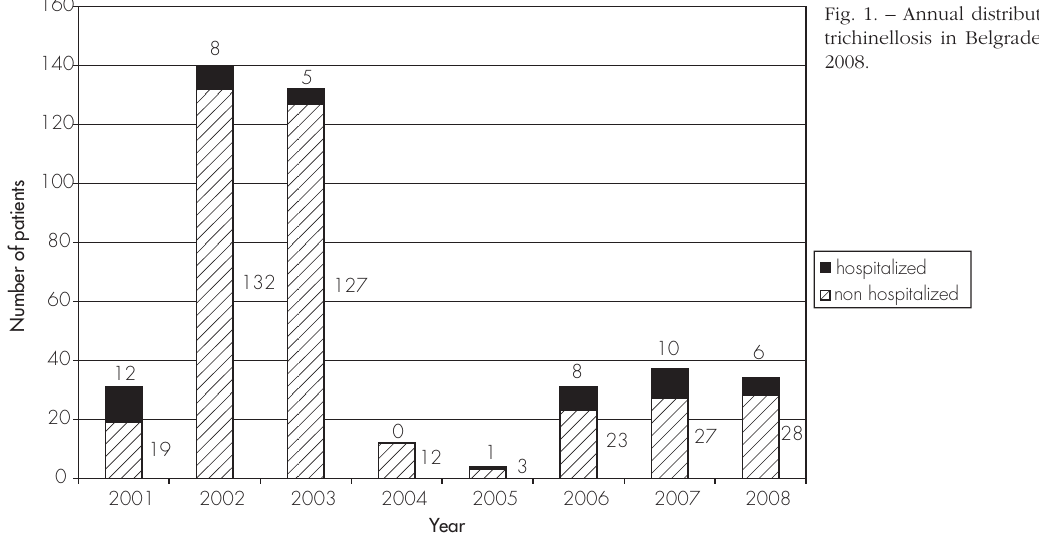
Fig. 1. – Annual distribution of patients with trichinellosis in Belgrade between 2001 and